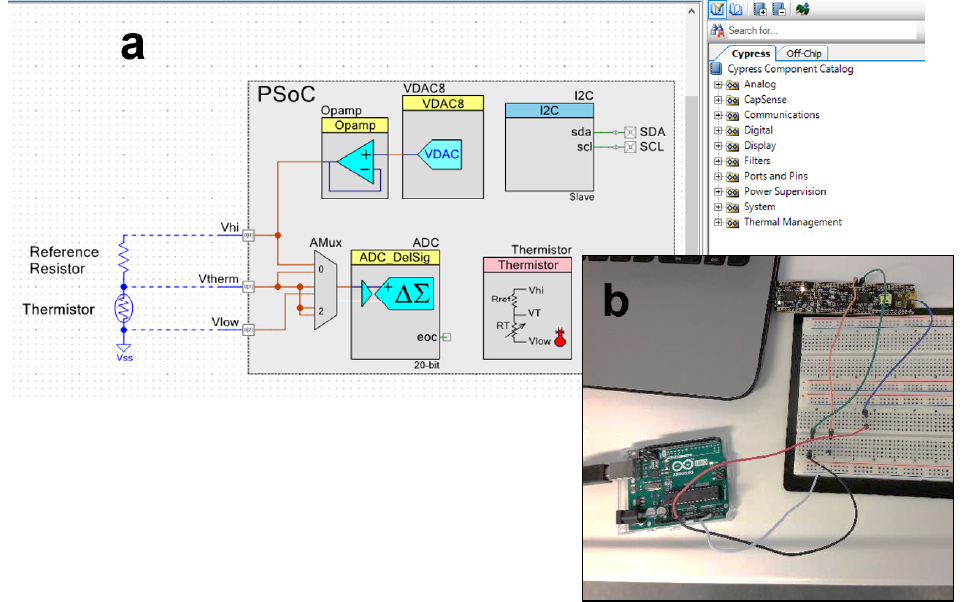
Figure 3. ( a ) Example of a PSoC ® Creator™ IDE design for a thermistor application. ( b ) Testing the I2C connection between Arduino UNO (master) and the PSoC ® platform (slave). I2C connection between Arduino UNO (master) and the PSoC ® platform